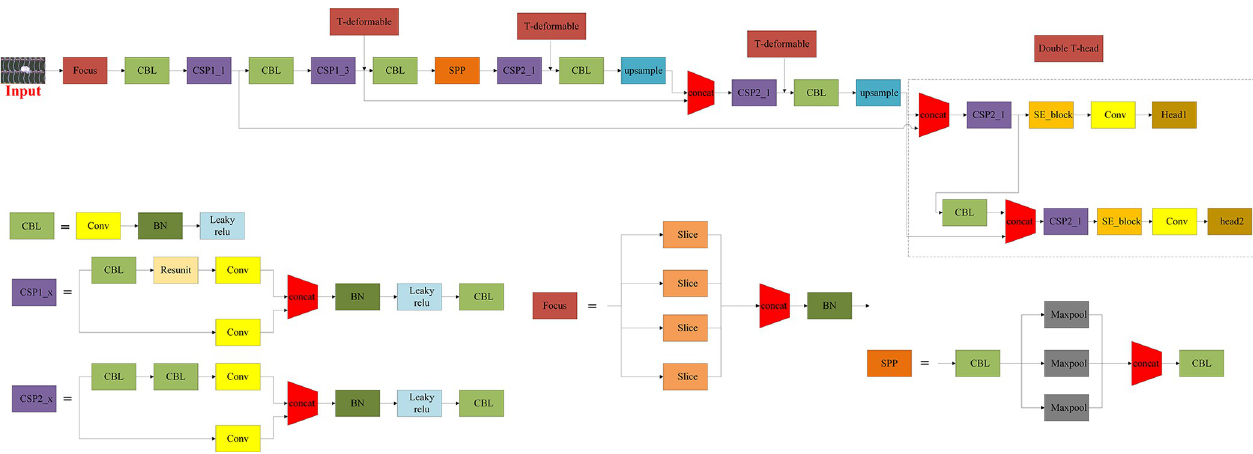
Fig 3. A more detailed network